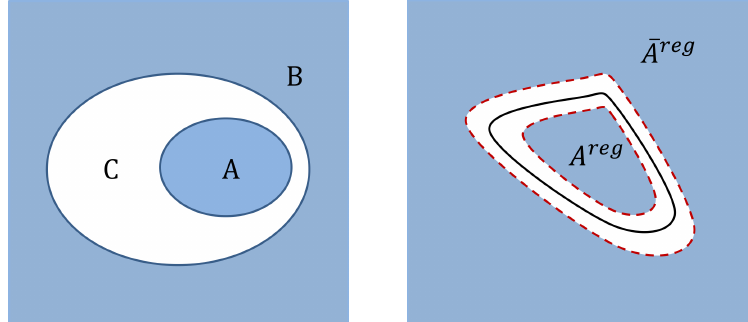
Figure 2: The quantity C ( A , B ) approaches the entanglement entropy under the ge- ometric regulator. In the right figure, the black solid line is the boundary between the region A and its complement ¯ A . We regularize these two regions to be A reg and ¯ A reg , while the white region is the cut-off region A cut ∪ ¯ A cut which should contain the boundary. The red dashed lines are the boundaries between regularized regions and the cutoff